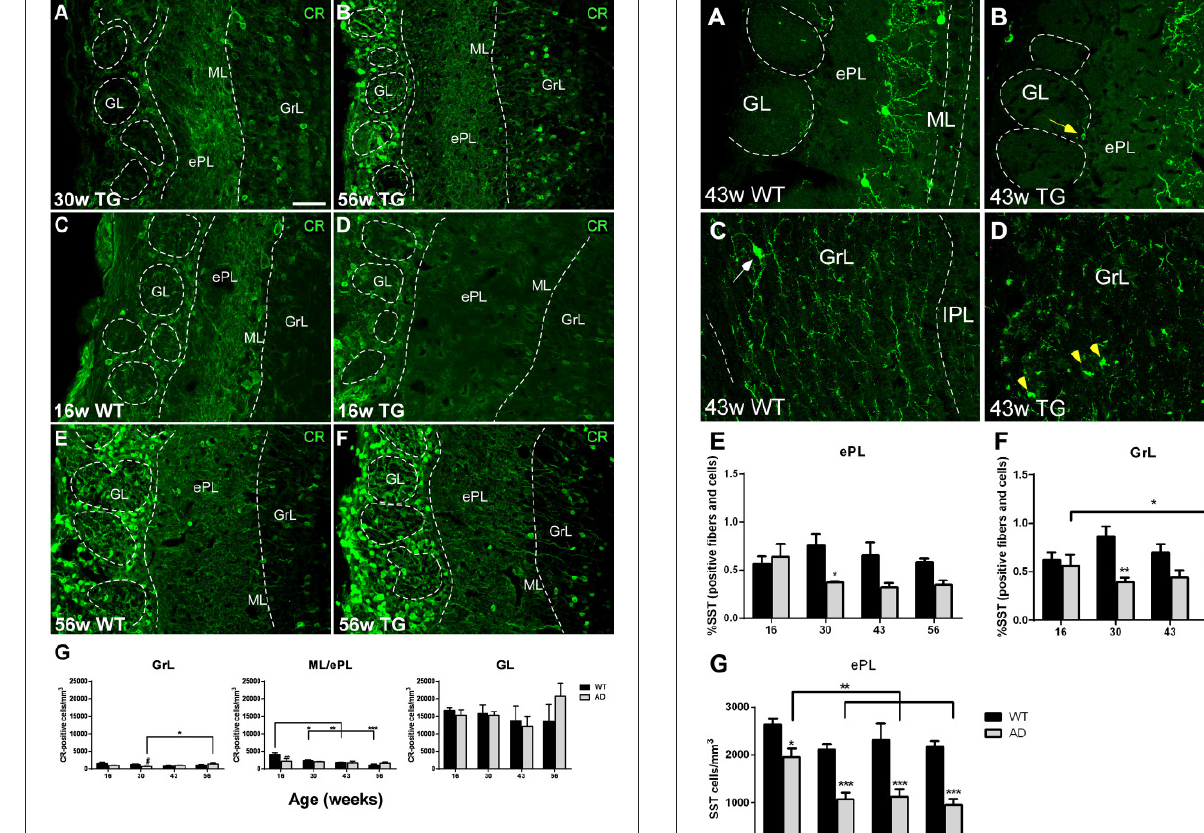
FIGURE 5 | Vulnerability analysis of calretinin-expressing cells in the olfactory bulb. (A–F) , confocal images showing calretinin-positive cells in the different layers of control and transgenic animals at distinct ages. (G) , graphics illustrating the estimation of calretinin-positive cells/mm 3 in control and transgenic animals in the different layers with aging. Calibration bar, 50 µ m. * P < 0.05 , ** P < 0.01 , *** P < 0.001 .